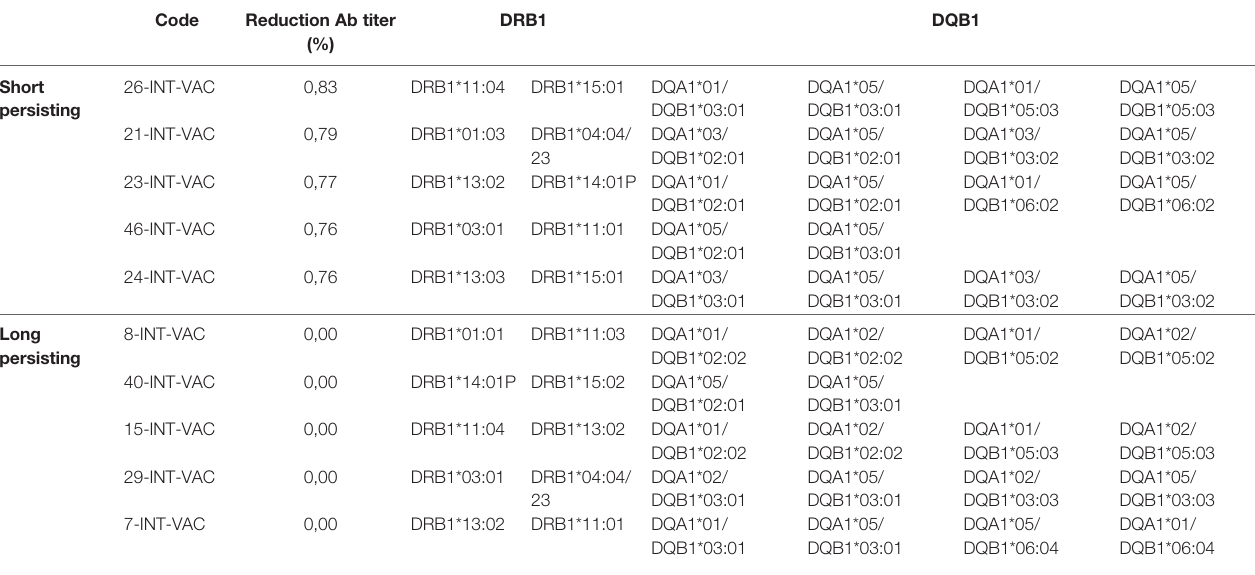
TABLE 4 | HLA DR and DQ alleles identi fi ed in the short and long persisting vaccinees.